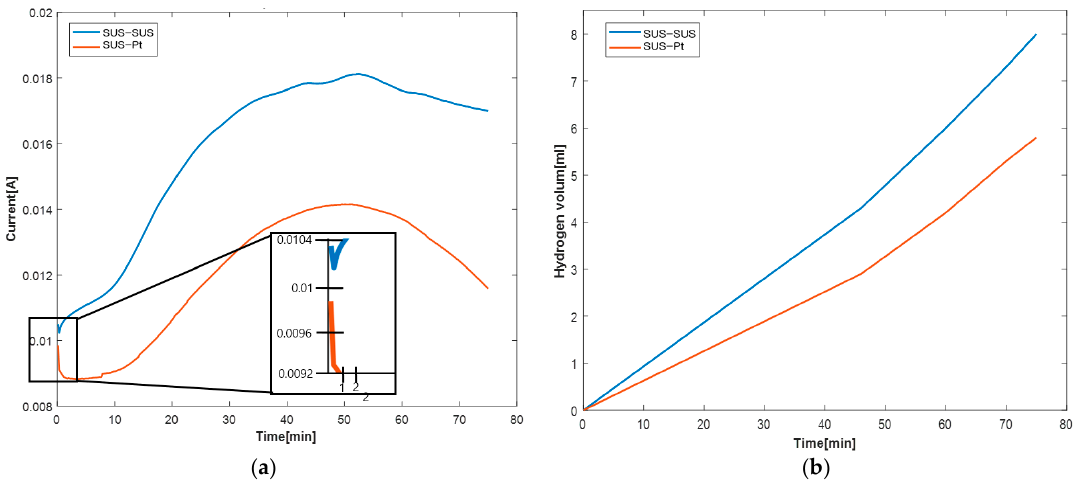
Figure 6. Experimental result according to anode material ( a ) Current ( b ) Hydrogen generation.